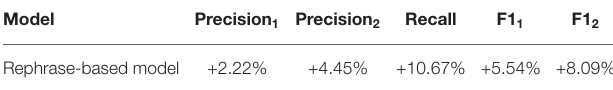
TABLE 4 | Experimental results on rephrase-based relabeling.